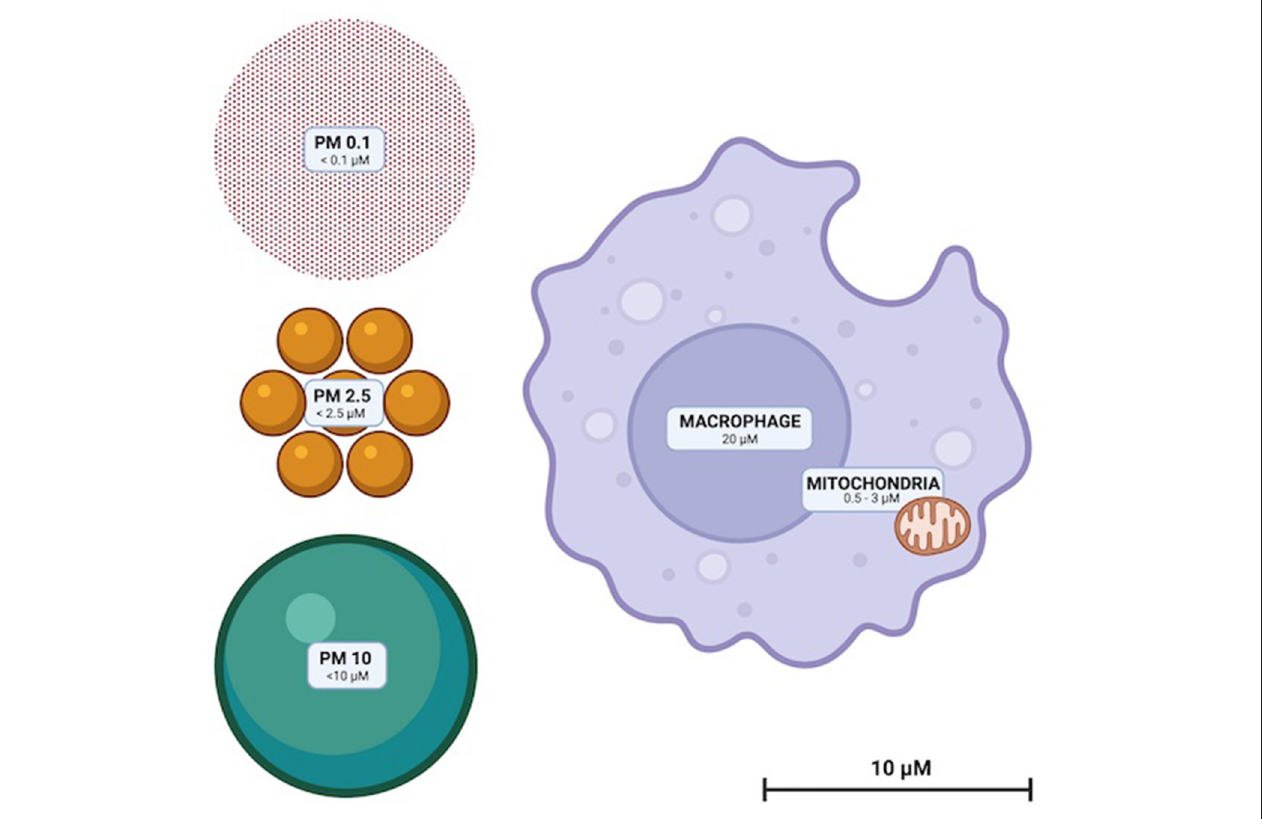
FIGURE 1 | To scale illustration of the relative sizes of PM10, PM2.5, and PM0.1. Representative macrophage and mitochondria are included to scale for reference.